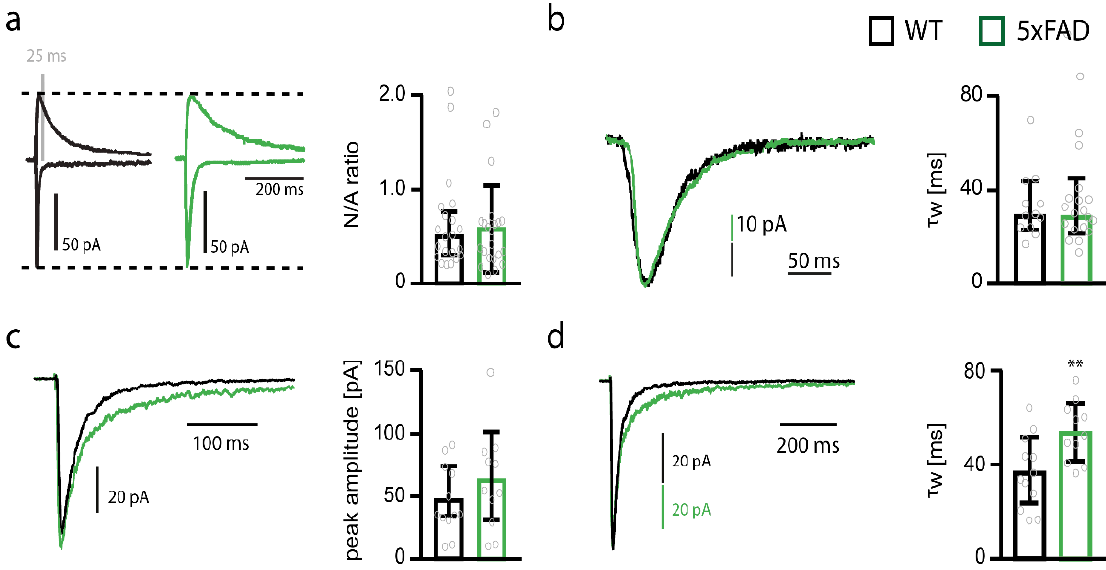
Figure 2. Deactivation time constant of extrasynaptic NMDAR currents increases in somatosensory cortex pyramidal cells of 5xFAD mice. ( a ) Example traces of NMDAR and AMPAR-mediated currents and bar graph of the NMDA/AMPA ratios (N/A ratios) of pyramidal cells from wildtype (WT) (black, n = 21) and 5xFAD (green, n = 22) mice. ( b ) Example traces and bar graph of the decay weighted tau (τ w ) of NMDAR-mediated currents of pyramidal cells from WT ( n = 12) and 5xFAD ( n = 20) mice. ( c ) Example traces of extrasynaptic NMDAR-mediated currents recorded by ultra-fast application of glutamate onto nucleated patches obtained from somatosensory cortex pyramidal cells of WT (black) and 5xFAD (green) mice. Peak amplitudes (WT n = 12 vs. 5xFAD n = 11) of NMDAR-mediated currents are shown in the bar graph. ( d ) Example traces of normalized extrasynaptic NMDAR-mediated currents recorded by ultra-fast application of glutamate onto nucleated patches obtained from somatosensory cortex pyramidal cells of WT (black) and 5xFAD (green) mice. Weighted time constants (τ w ) of NMDAR-mediated current deactivation are shown in the bar graph (WT n = 12 vs. 5xFAD n = 11). Data in bar graphs are shown as median ± interquartile range. Empty grey circles depict single data points. t -test: ** p < 0.001.